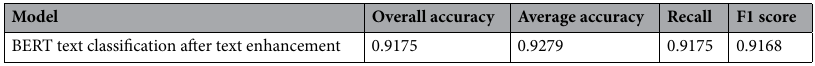
Table 3. Overall evaluation of the shallow text citation tags.